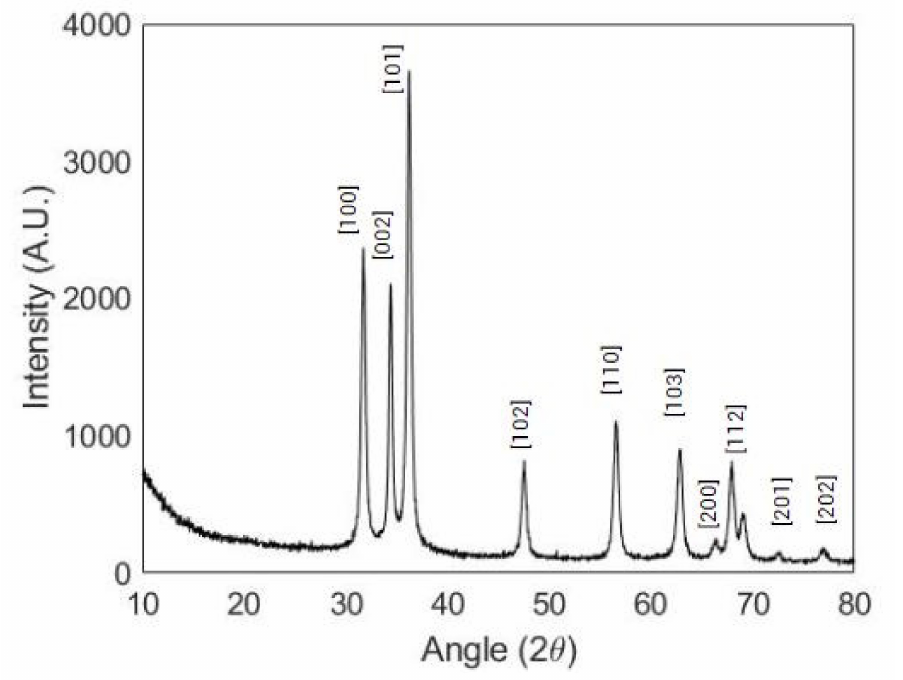
Figure 2. XRD pattern of